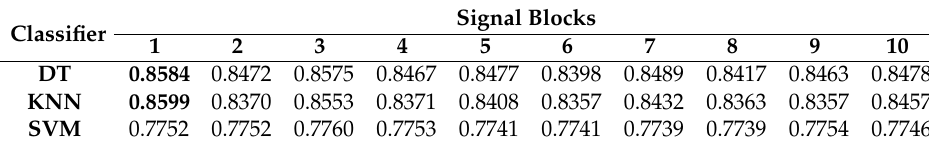
Table 7. Average accuracy rate for signal blocks using classifiers DT, KNN and SVM.